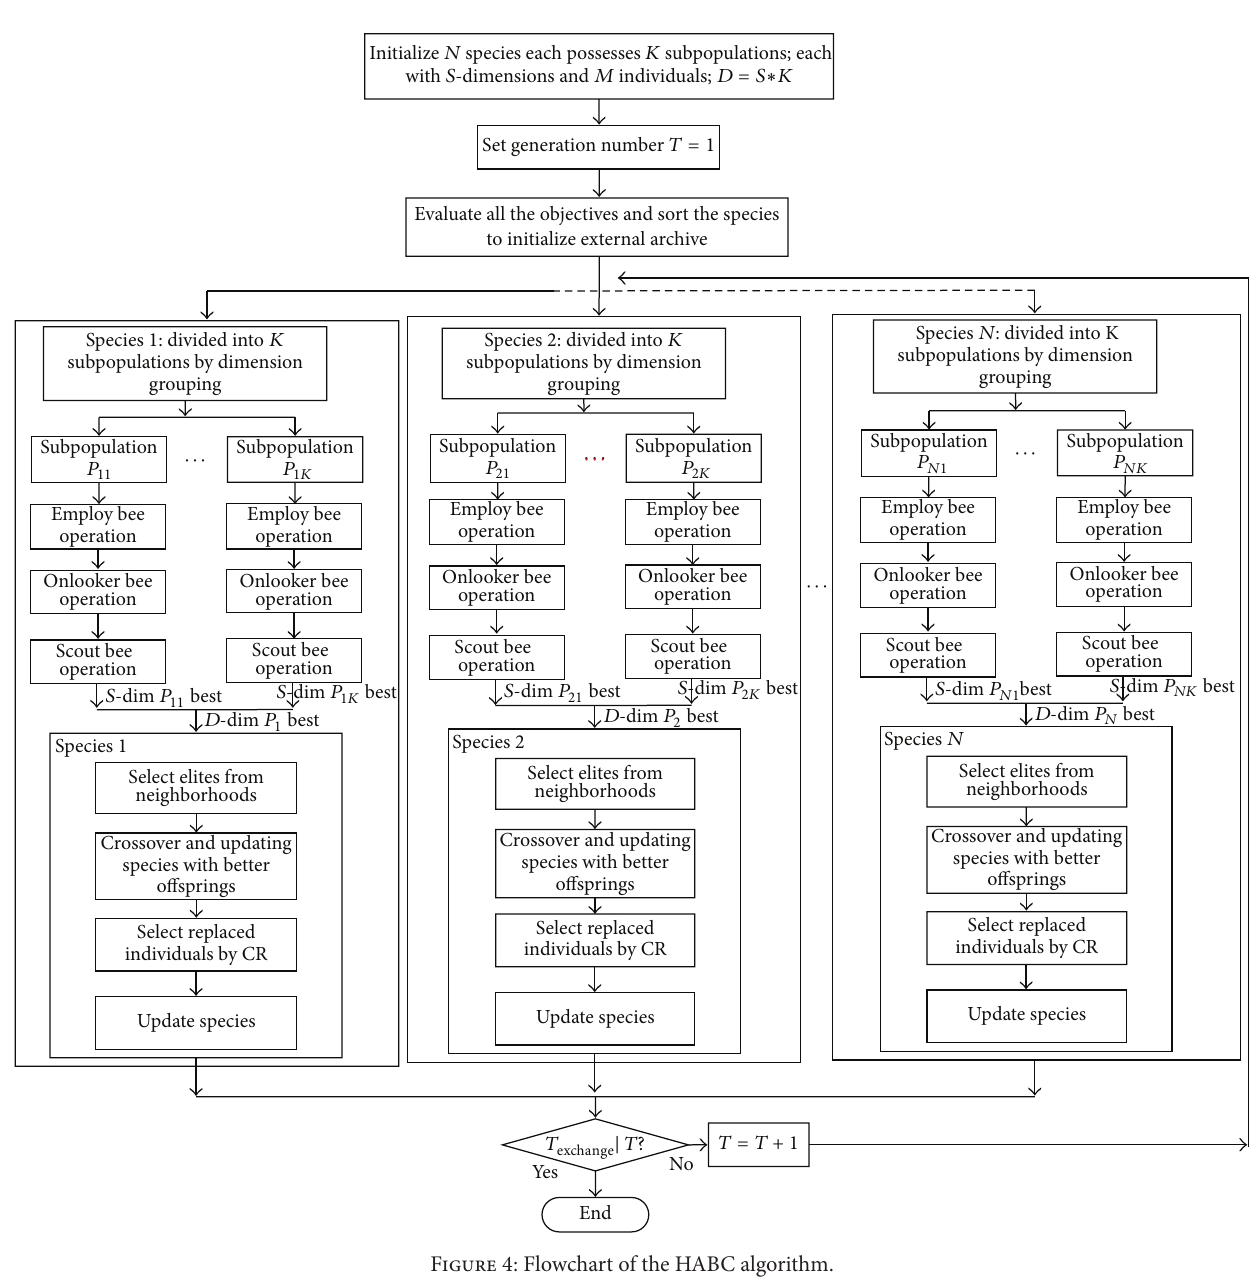
Figure 4: Flowchart of the HABC algorithm.